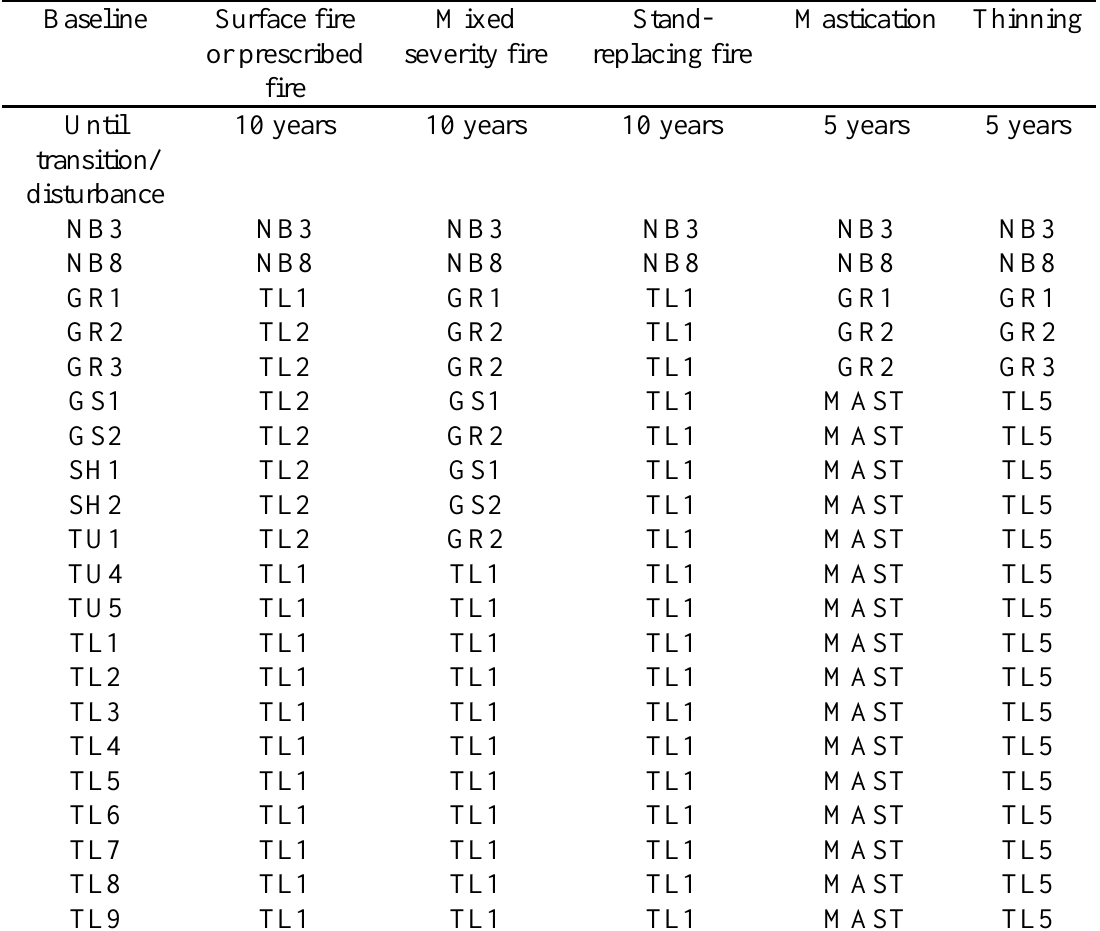
Table A2.3. Fuel model codes assigned to post-disturbance conditions. All models are described in Scott and Burgan (2005) with exception of MAST, a custom fuel model for masticated fuel